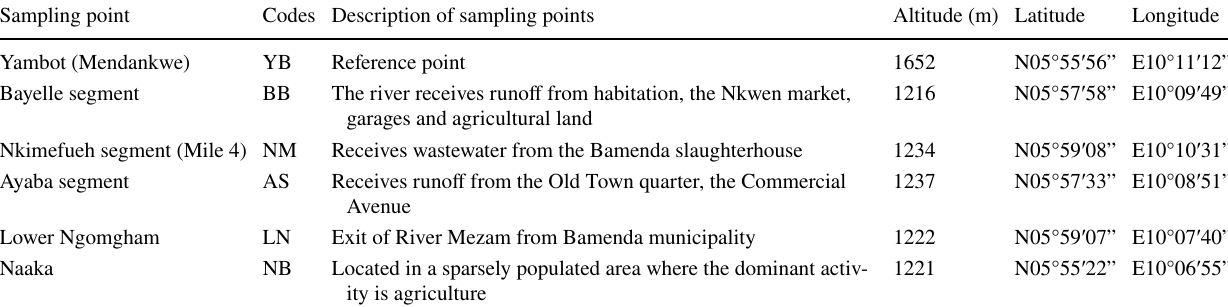
Table 1 Sampling points and their corresponding codes in the study area Sampling point